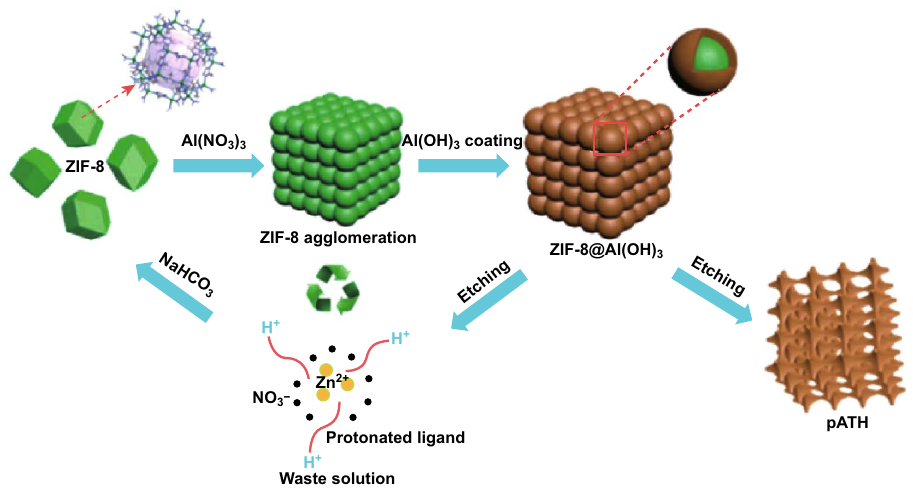
Fig. 7 Schematic illustration of the synthetic procedure for pATH. Adapted from Ref. [55] with permission from the Royal Society of Chemis‑ try